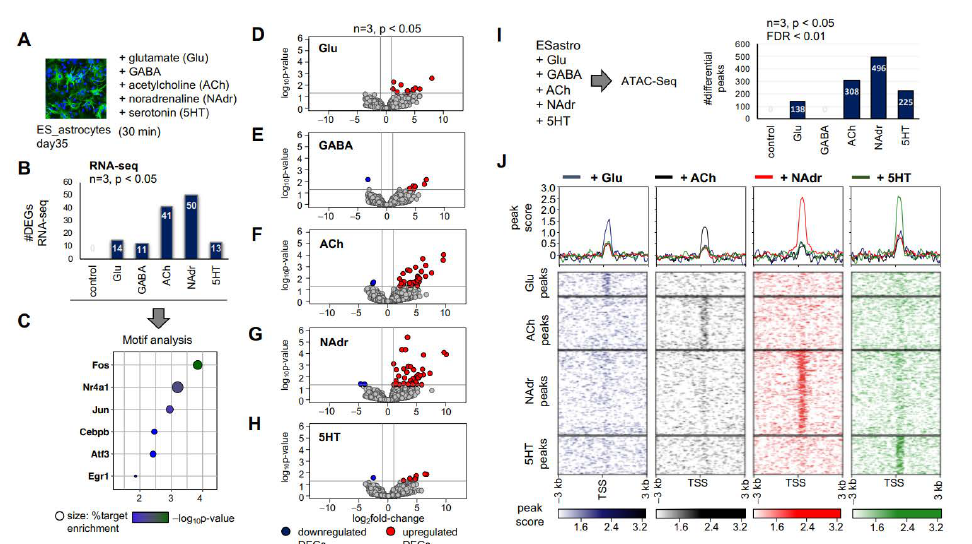
Figure 4. Neuroactive chemical-induced gene regulation in mES_astrocytes. ( A ) Schematic of stimulation of mES_astrocytes by a panel of neuroactive chemicals. ( B ) Bar graph showing the total number of DEGs from RNA-Seq for each chemical ( n = 3, p < 0.05, fold-change > 2). DEG lists associated with each chemical are given in Table S2. ( C ) Significant transcription factor motifs ( p < 0.01) enriched in all DEGs shown in (B). ( D – H ) Volcano plots showing significance versus log 2 fold-change depicting RNA-Seq data comparing transcriptomes in response to ( D ) Glu, ( E ) GABA, ( F ) ACh, ( G ) NAdr, and ( H ) 5HT ( n = 3, p < 0.05, fold-change > 2). ( I ) Schematic of assays for transposase- accessible chromatin (ATAC)-Seq experiment and bar graph showing the total number of genes with differential peaks for each chemical ( n = 3, p < 0.05, FDR for peak enrichment < 0.01). ( J ) Heatmap of ATAC-Seq analysis depicting chromatin peaks that become accessible in response to chemicals. Peaks within 3 kb of transcription start sites are shown ( n = 3, p <